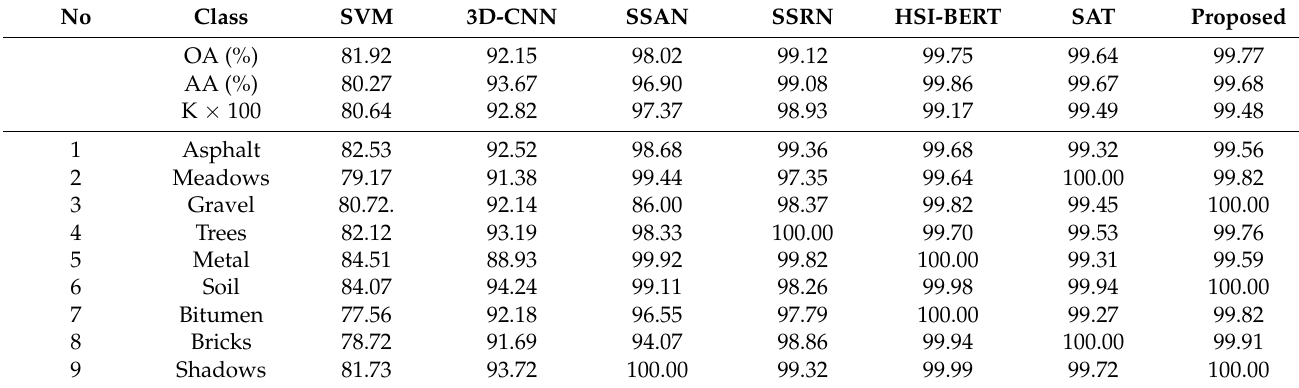
Table 7. Classification results of various methods for the UP Dataset.